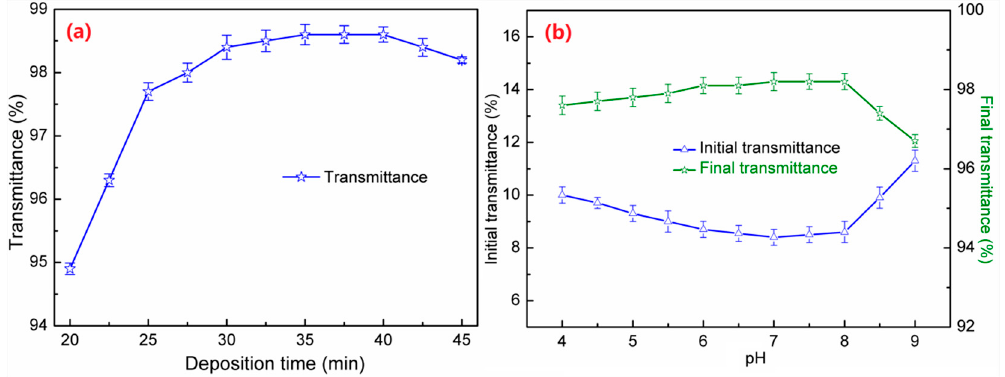
Figure 5. Effect of ( a ) deposition time and ( b ) pH on transmittance.